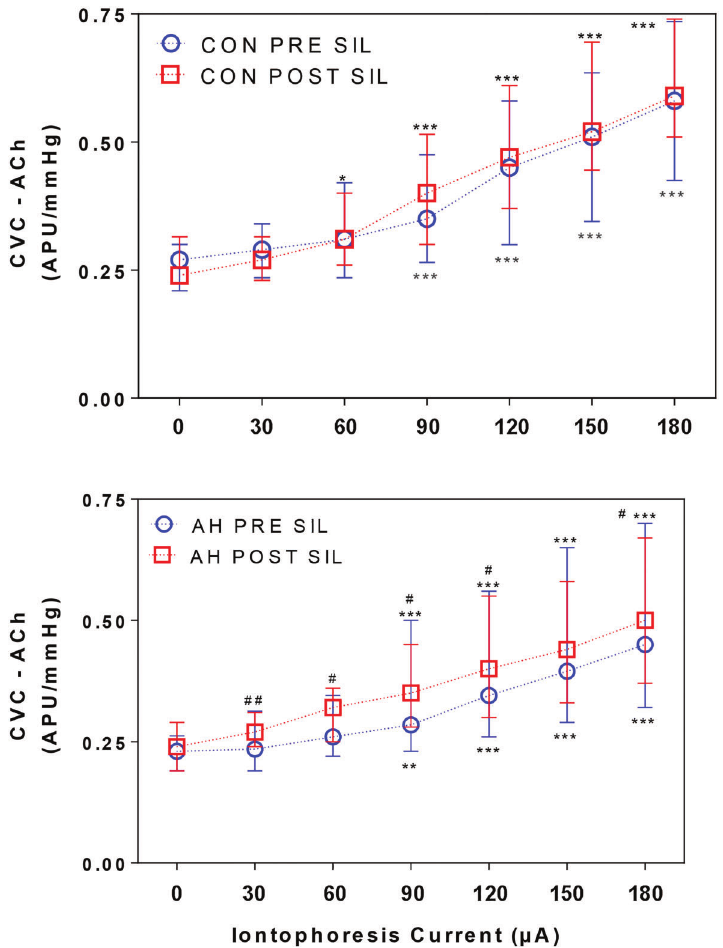
Figure 2 . Effects of forearm skin acetylcholine (ACh) iontophoresis on cutaneous microvascular conductance (CVC), in arbitrary perfusion units (APU) divided by mean arterial pressure in mmHg in healthy volunteers (upper panel, CON; n=33) and hypertensive patients (lower panel, AH; n=34) before (PRE SIL) and after (POST SIL) oral sildena fi l (100 mg) administration. Data are reported as medians (interquartile range) and were analyzed using Wilcoxon ’ s test, the Mann- Whitney U-test or repeated measures analysis of variance followed by Dunnett ’ s multiple compar- ison test when appropriate. *P o 0.05, **P o 0.01 and ***P o 0.001 compared with baseline values. # P o 0.05 and ## P o 0.01 compared with PRE